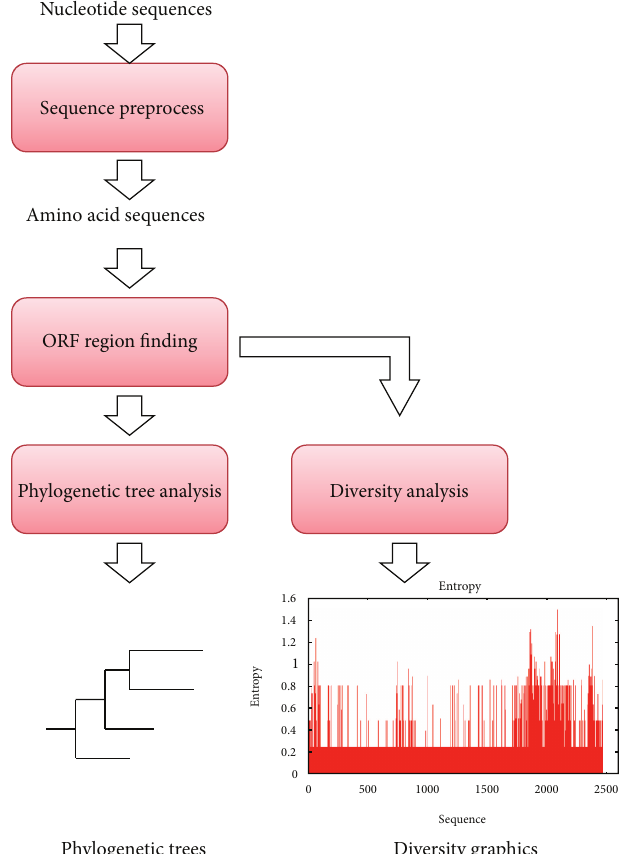
Figure 1: The phylogenetic analysis